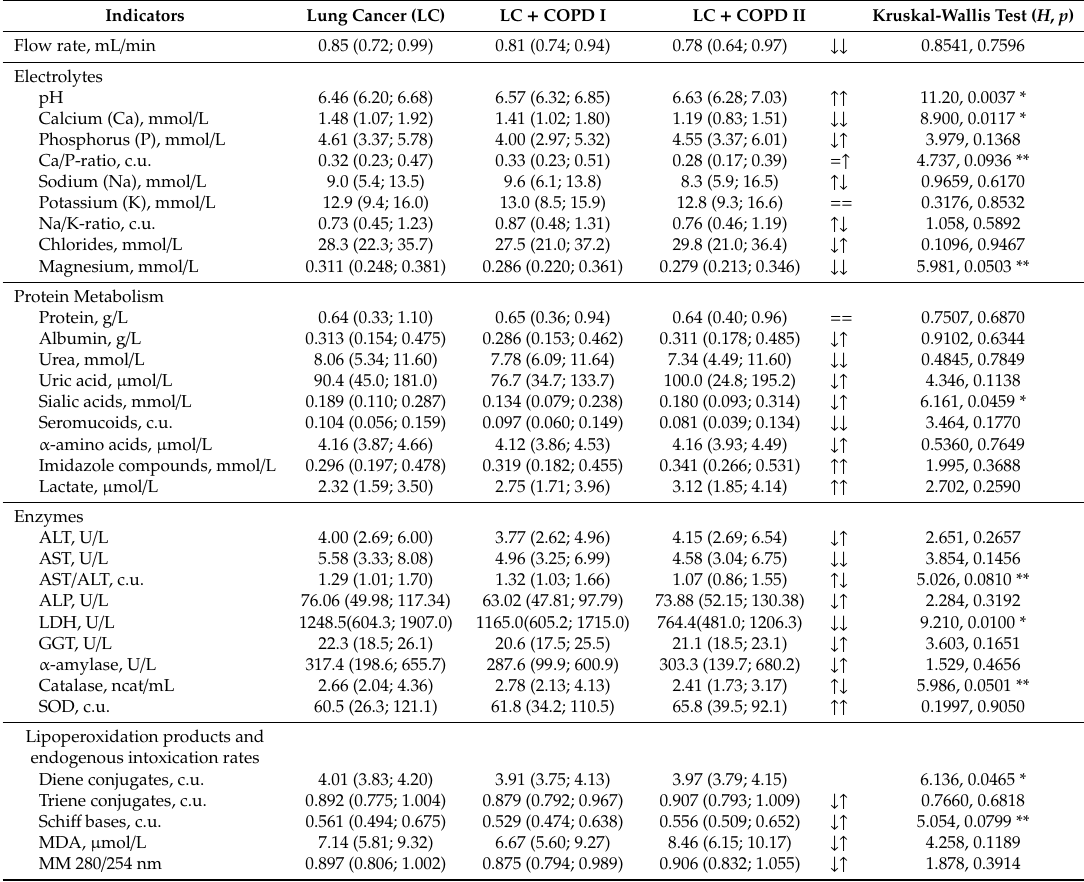
Table 2. Biochemical markers of saliva in patients with lung cancer, depending on the presence / absence and severity of cancer, chronic obstructive pulmonary disease (COPD).